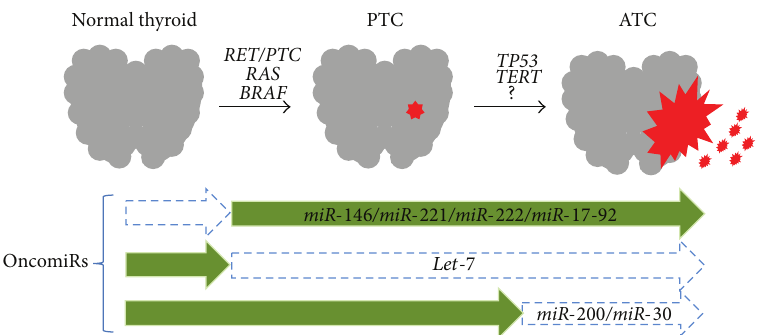
Figure 3: Thyroid oncogenesis and miRNAs. Activation of MAPK oncogenes by mutations or rearrangements leads to PTC. Progression to ATC may be associated with the acquisition of additional genetic alterations such as TP53 mutations. Deregulation of miRNA occurs during thyroid oncogenesis, with specific upregulation of miRNAs such as miR-146 , miR-221 , miR-222 , and miR-17-92 cluster, and loss of let-7 expression, in both PTC and ATC. Exclusive downregulation of miRNAs, such as miR-200 and miR-30 , is observed in